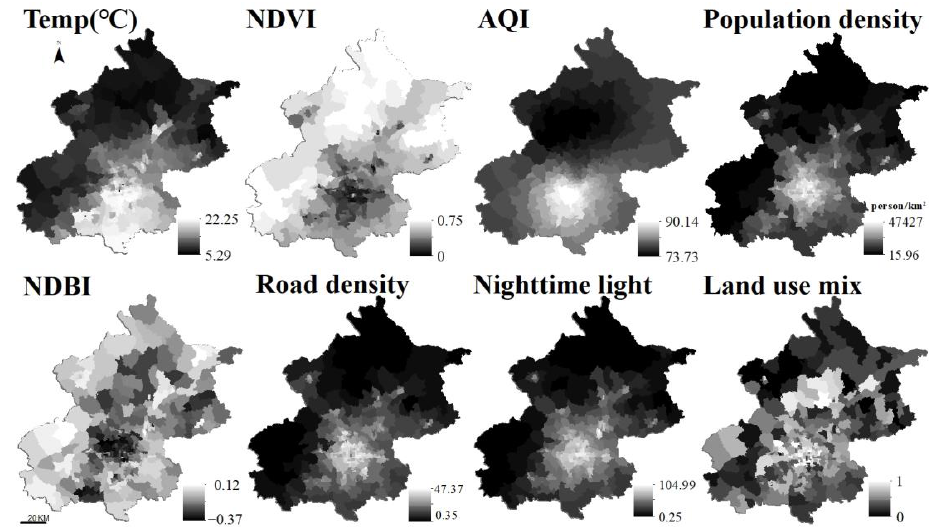
Figure 5. Spatial distribution of eight annual associated factors.